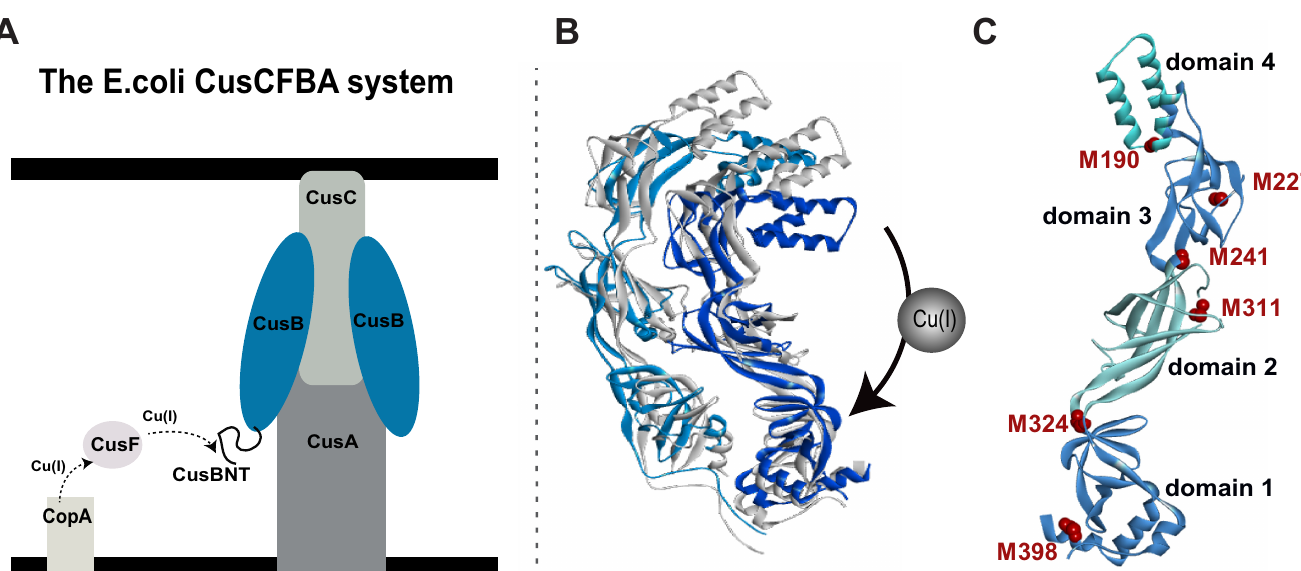
Fig 1. The CusCBA efflux system. A. A schematic view of the CusCFBA periplasmatic efflux system. Cu(I) is transferred from the CusF metallochaperone to the N- terminal domain of CusB (CusB_NT) and out of the cell through CusB and CusC proteins by an unknown transfer mechanism. B. The CusB dimer structural models for apo-CusB (gray protein) and holo-CusB (blue colors) based on EPR constraints. C. The positions of the methionine residues (red colors) in the crystal structure of CusB monomer (PDB 3H94); residues 1–88 are missing from the crystal